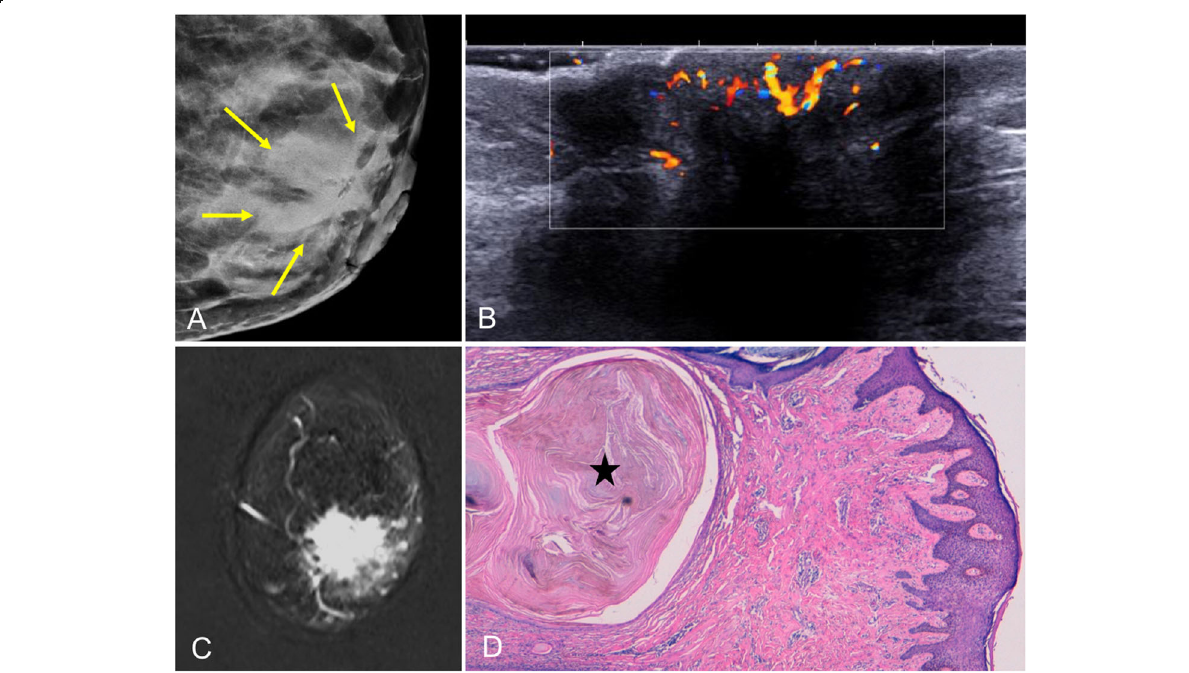
Fig. 27 Syringomatous tumor of the nipple. A 47-year-old woman with retraction and hardening of the left nipple. a Mammogram shows retraction of the left nipple and asymmetric retroareolar density. b On ultrasound, the lesion is solid and hypoechogenic with ill-defined borders and increased peripheral color-Doppler signal. c Contrast-enhanced coronal T1-weighted MRI (subtracted image obtained 120 s after contrast injection) shows mass- type uptake with pronounced early enhancement in a lesion with hazy borders that retracts the nipple-areolar complex. d Hematoxylin-eosin stain (× 4) shows a proliferation of elongated glandular structures like strings of cells in the dermis, with the formation of keratin cysts (star)